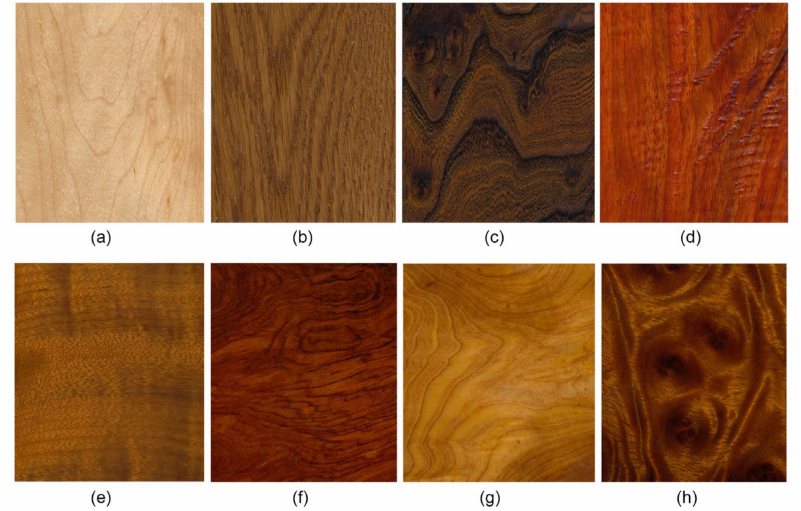
Figure 3. ( a ) Natural color hinoki, ( b ) brushed oak ( c ) antique finished elm ( d ) distressed Pterocarpus , ( e ) Phoebe ( f ) Dalbergia , ( g ) camphorwood, and ( h )